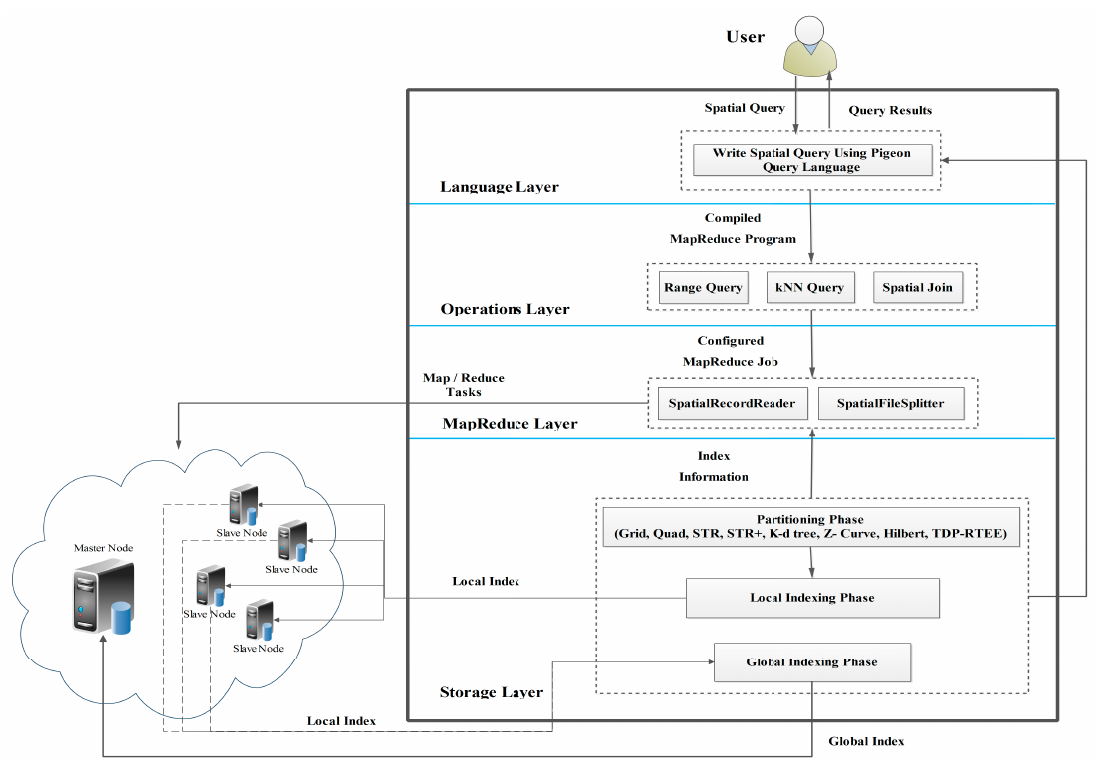
Figure 1. SpatialHadoop system architecture [12].